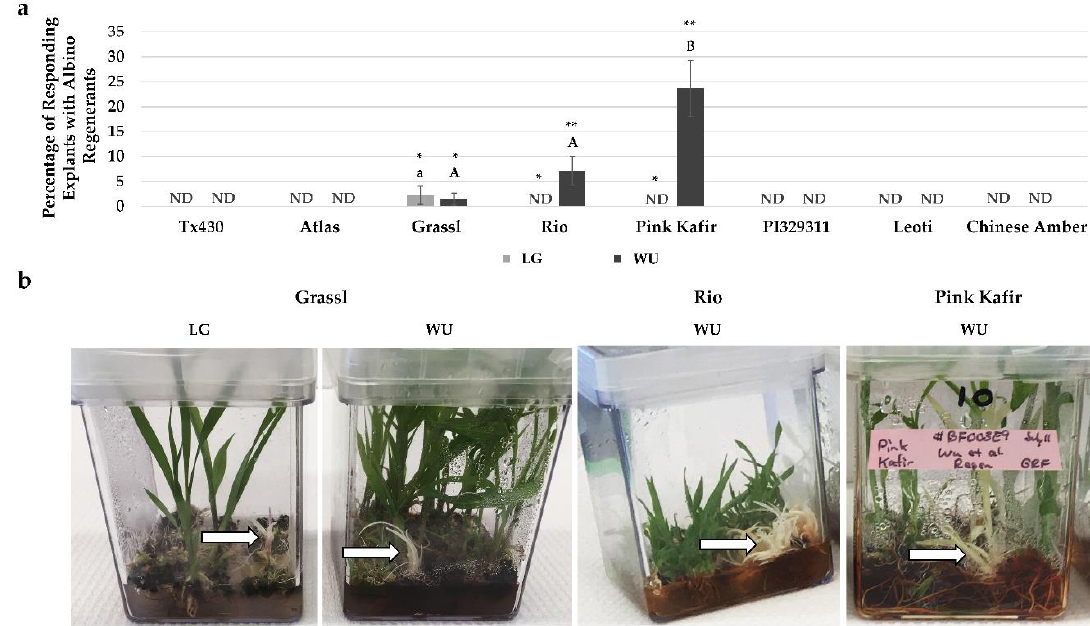
Figure 6. Impact of LG and WU protocols on the incidence of albino regenerants for the various genotypes. ( a ) Percentage of regenerating explants exhibiting albino plantlet regeneration, following eight weeks in culture. Results are plotted as the mean of three independent experiments ( ± SE). ND, not detected. ( b ) Representative images of cultures for genotypes exhibiting albino regeneration for specific genotype and protocol combinations. Data shown in ( a ) were analyzed by one-way ANOVA, and tested for significance using Tukey’s HSD Post-hoc Test. For comparisons across genotypes for the LG protocol, those with the same lowercase letter are not significantly di ff erent at p ≤ 0.05. For comparisons across genotypes for the WU protocol, those with the same uppercase letter are not significantly di ff erent at p ≤ 0.05. For comparisons across the two media within a genotype, those with the same asterisk pattern are not significantly di ff erent at p ≤ 0.05.